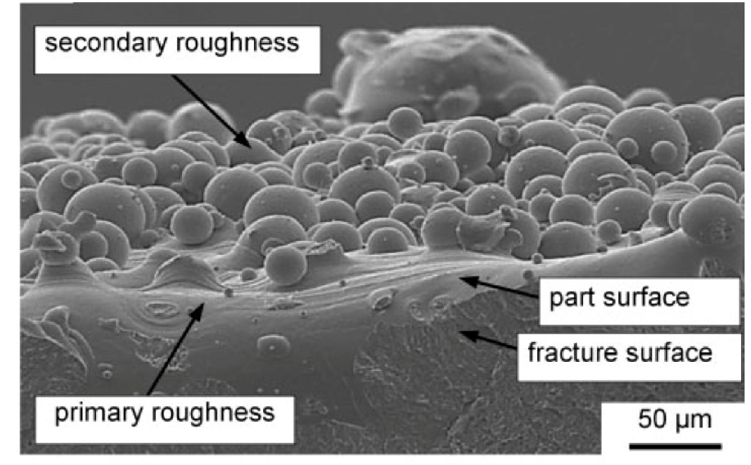
Figure 9. Typical surface roughness of Ti6Al4V produced by Laser Powder Bed Fusion.